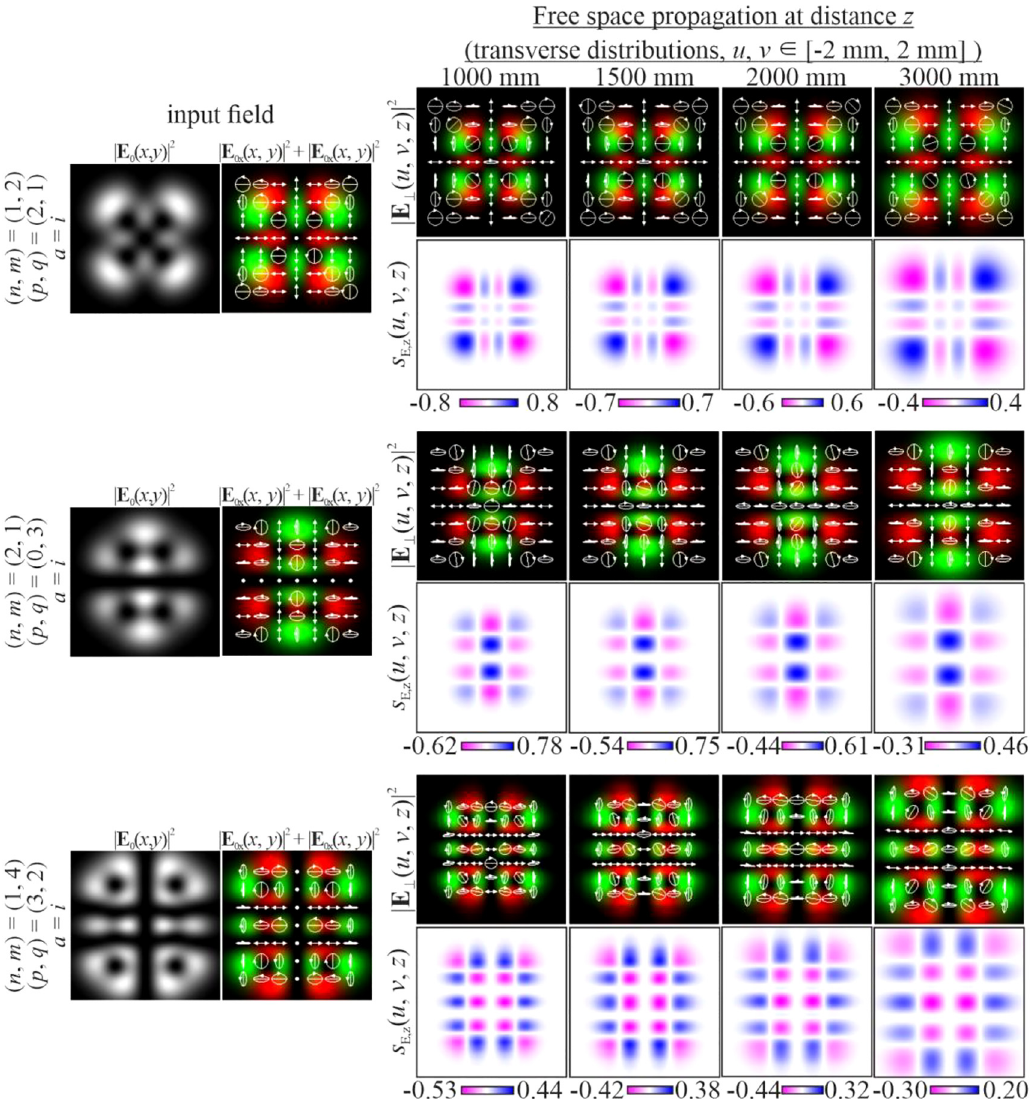
Figure 4: Propagation of inhomogeneously polarized beams defined by Eq. (27) with indices ( n + m ) = ( p + q ) (nonuniformly polarized vector modes) at the initial phase shift a = i